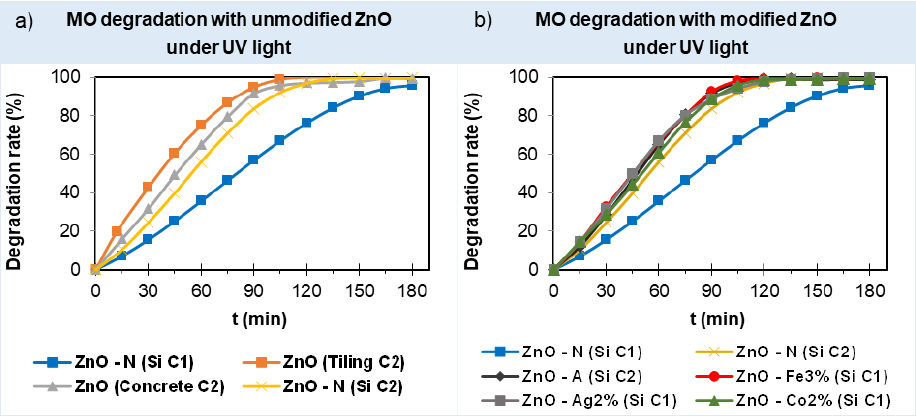
Figure 6. MO degradation with unmodified ( a ) and modified ( b ) ZnO grown onto different substrates under UV light (~365 nm, I received by the sample = 35 mW/cm²).